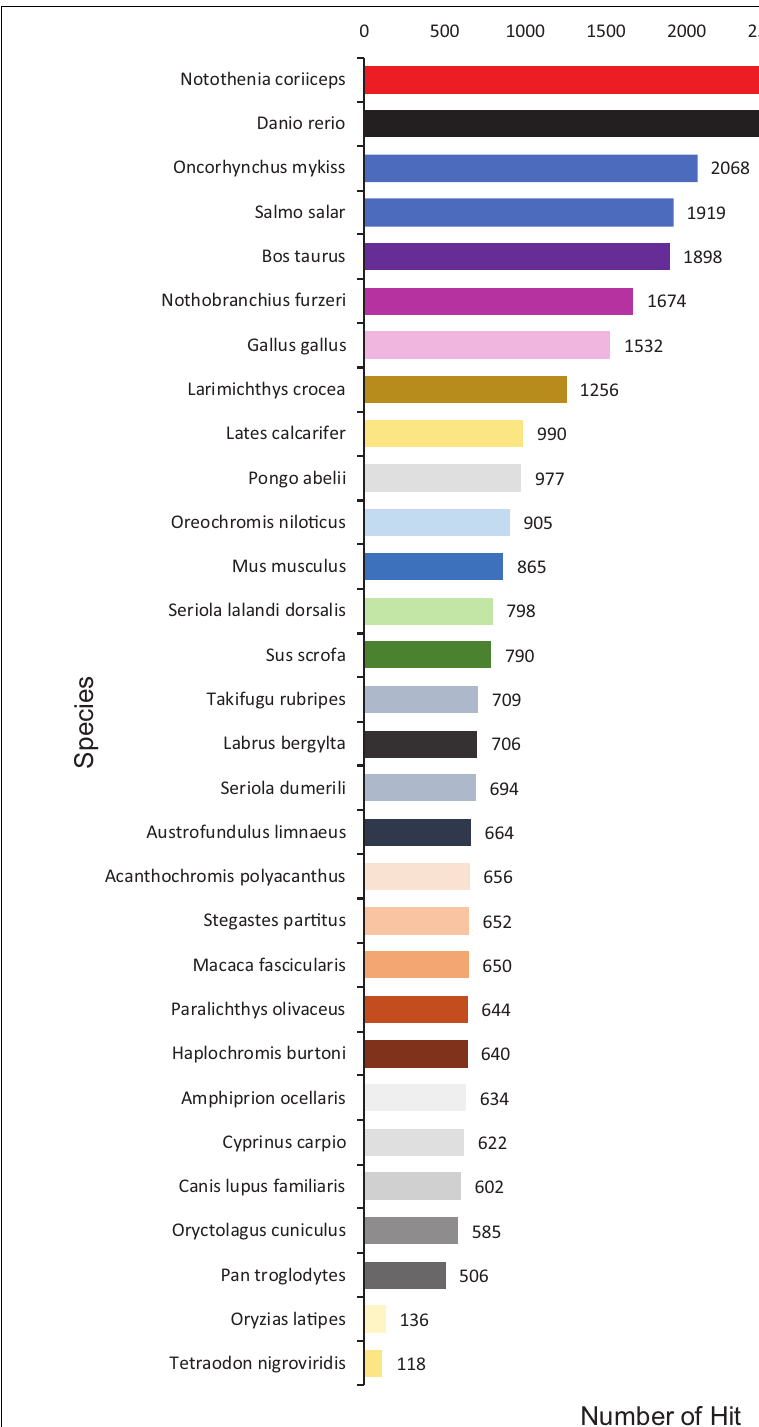
FIGURE 1 | Species that match the annotated sequences of Patagonian toothfish. Species distribution of the top BLAST hits for all homologous sequences.